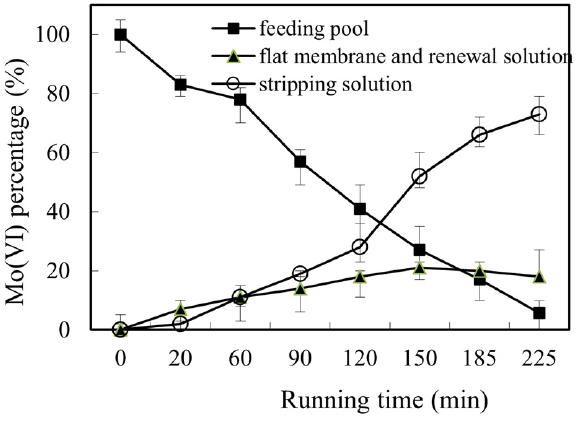
Figure 6. The retention of Mo(VI).